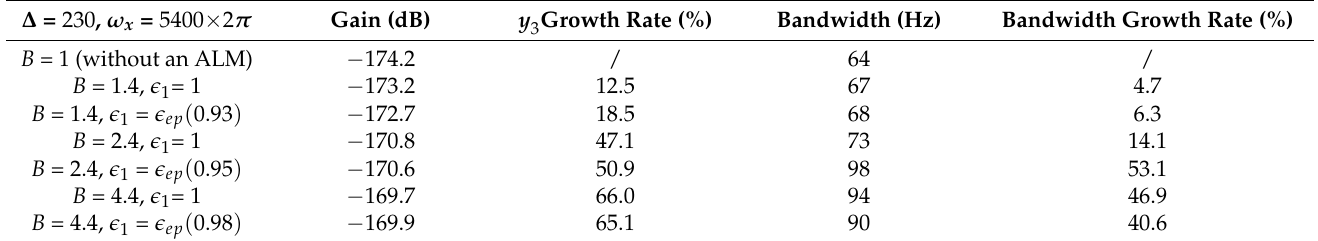
Table 2. Gain and bandwidth of linear micro-gyro under typical